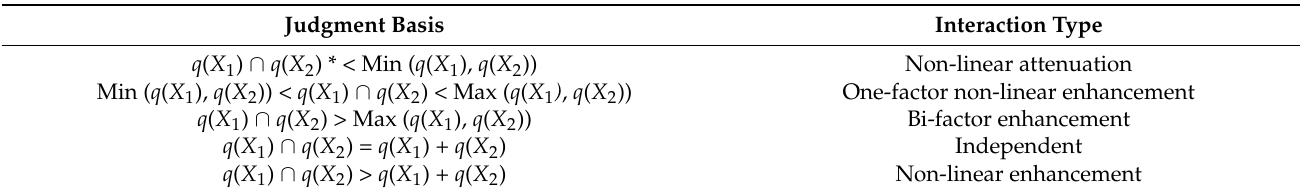
Table 1. Types of interaction between two